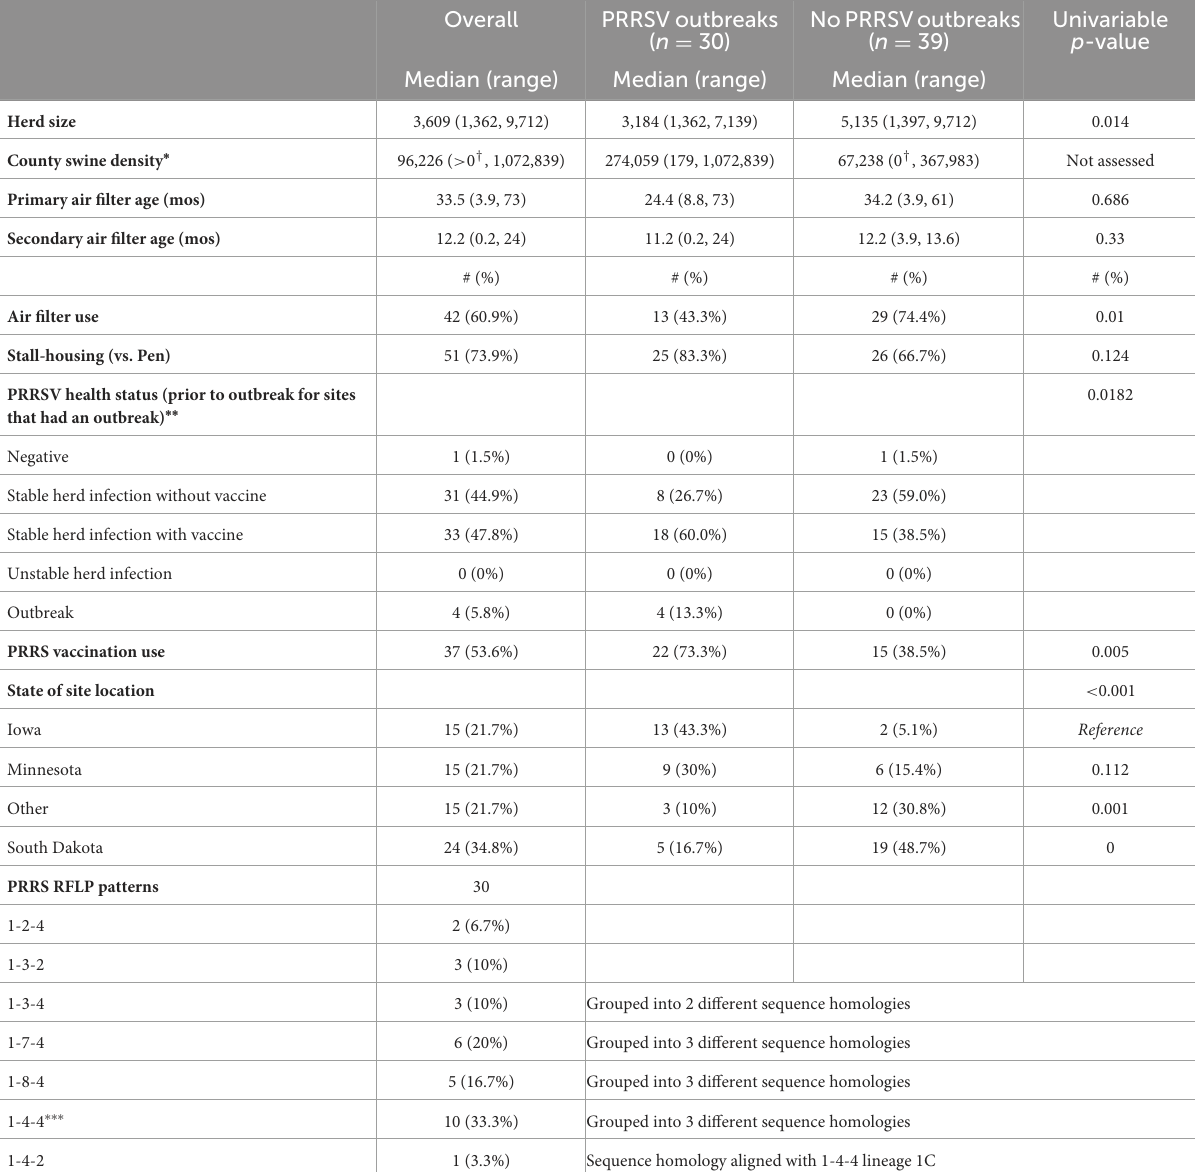
TABLE 1 Summary of PRRSV-infected farrow-to-wean farm characteristics and associated univariable analysis in the Pipestone Management System from January 2019 to January